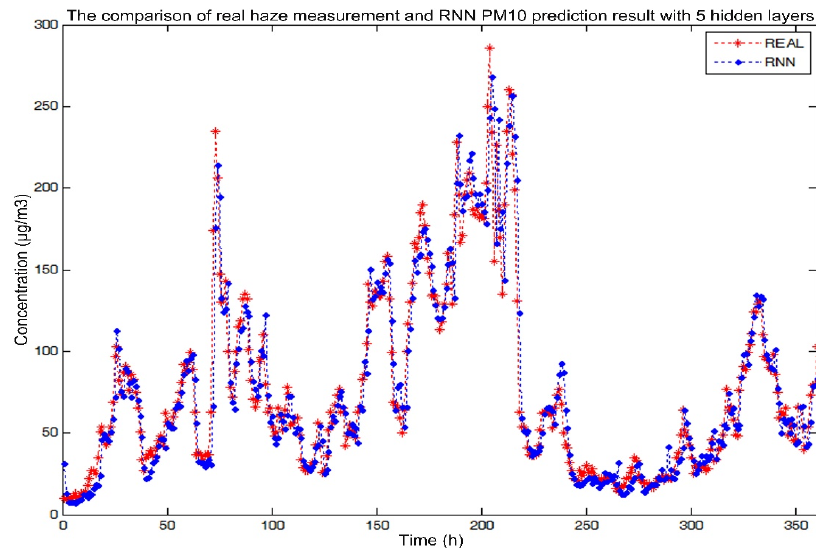
Figure 7. PM10 prediction results of 5 hidden layers of RNN network.